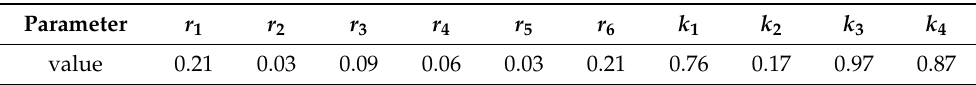
Table 1. Calibration results of Equation (3).